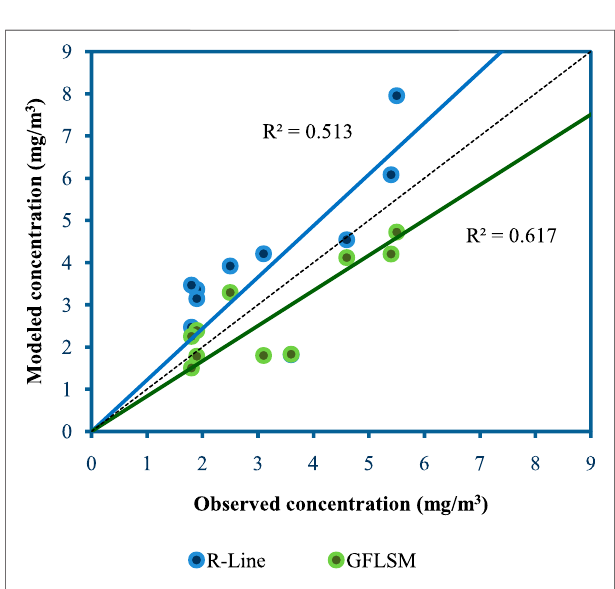
FIGURE 3 | Comparison between the performance of the GFLSM and R-Line